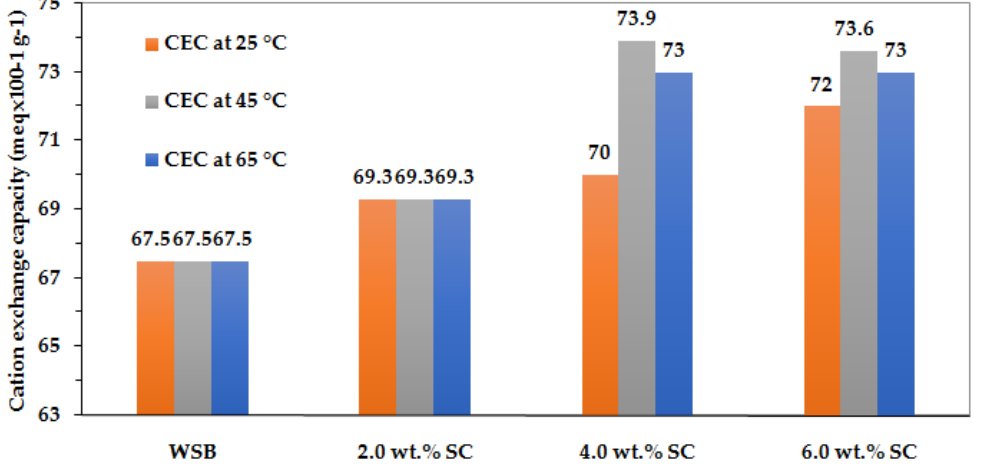
Figure 5. Effect of temperature and Na 2 CO 3 concentration on CEC at fixed time (3 h). Note: WSB — wet sieved bentonite; SC — sodium carbonate.